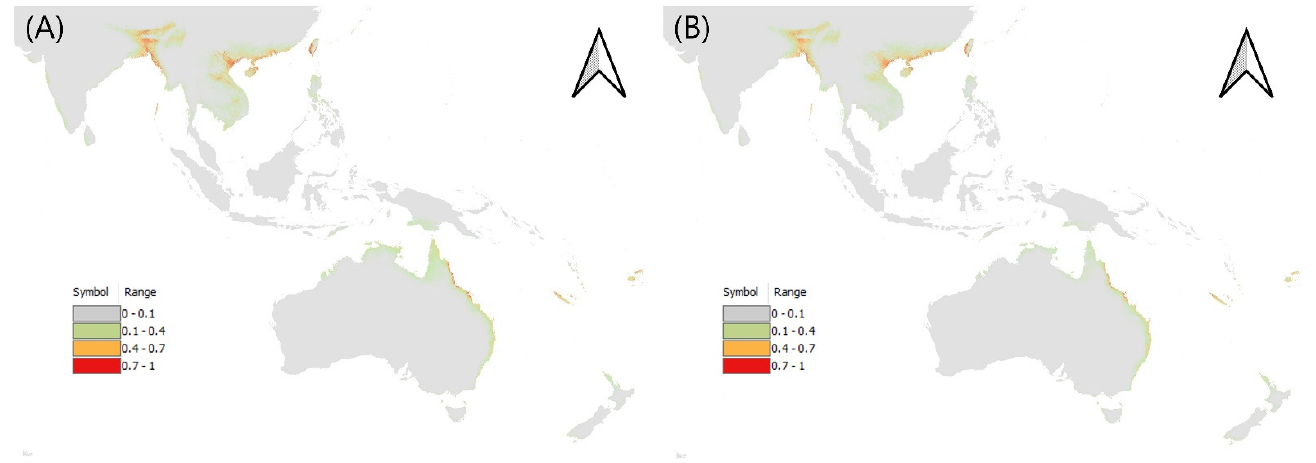
Figure 3. Potential distribution of L. acuta ( A ) under current climate, and ( B ) for 2081–2100. For L. oratoria , the precipitation of the wettest month and the minimum temperature of the coldest month showed high contributions. Other environmental variables, the precipitation of the driest quarter, the annual temperature range, land cover, the precipitation of the warmest quarter, the precipitation of the coldest quarter, and the elevation contributed little. In the potential distribution map of L. oratoria , the possibility of occurrence was high, mainly in tropical areas, corroborating previous reports [6,8,39,44]. Based on climate change, it was predicted that a higher density would be observed in most tropical areas (Figure 4, Supplementary Figures S8 and S9).